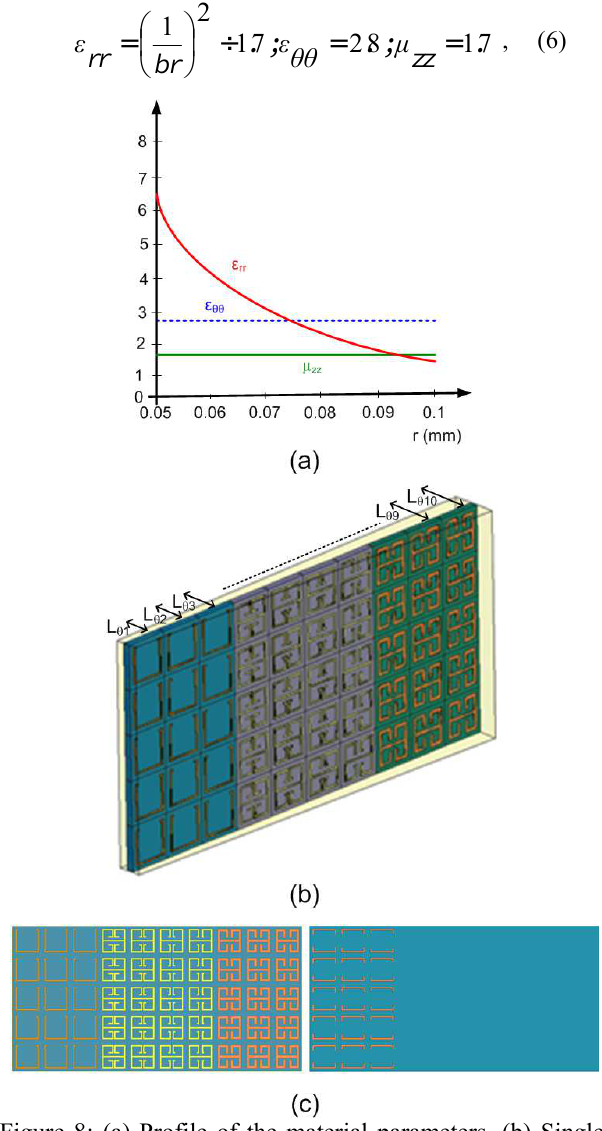
Figure 8: (a) Profile of the material parameters. (b) Single metamaterial layer composed of 10 unit cells providing the material parameters necessary for the coordinate transformation. (c) Front and rear view of the metamaterial